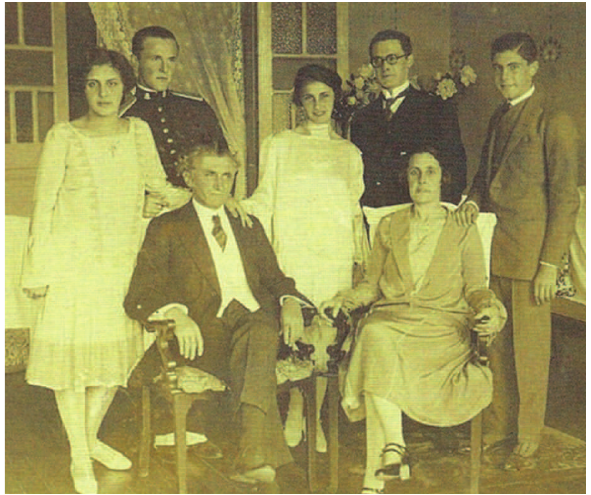
Fig. 1 – O casal Eugênio e Ernestina Zerbini e os filhos. O Dr.